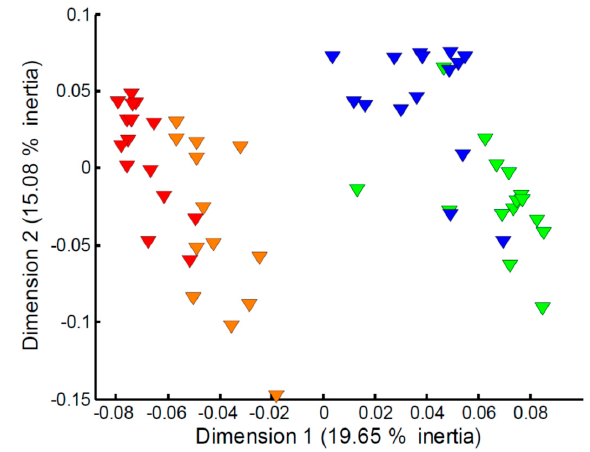
Figure 4. Multiple correspondence analysis of the metabolites captured on the SDB-RPS receiving phase in the trout tanks and measured via mass spectrometry metabolomics. Metabolite data were represented in an indicator matrix (presence/absence). MANOVA of scores, p < 1.0 × 10 − 3 , and all pairwise comparisons between four time points, p ≤ 1.6 × 10 − 3 ). Key: metabolites captured in week 1 (red), week 2 (orange), week 3 (green) and week 4 (blue). (red), week 2 (orange), week 3 (green) and week 4